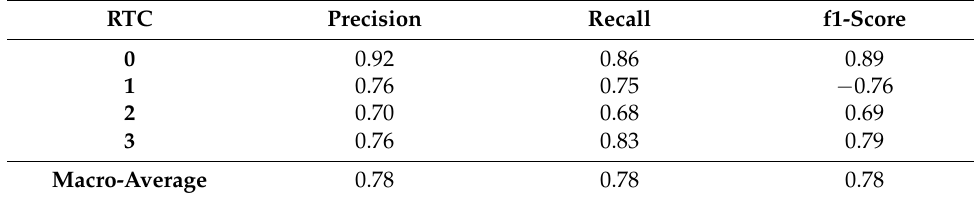
Table 9. Performance of RTC.